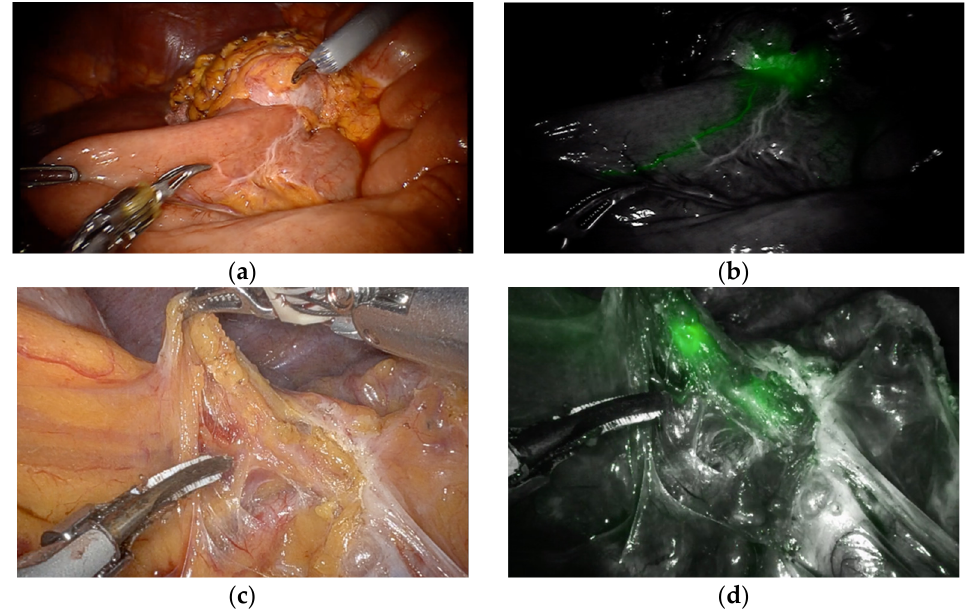
Figure 1. ( a ) White-light image of RGC after distal gastrectomy with gastrojejunostomy; ( b ) fluores- cent imaging of “Figure 1a” showing lymphatic drainage to jejunal mesentery from the tumor located in the anastomosis site; ( c ) white-light image of distal splenic artery area in remnant gastric cancer; ( d ) fluorescent image of “Figure 1c” showing fluorescent LNs along the distal splenic artery.